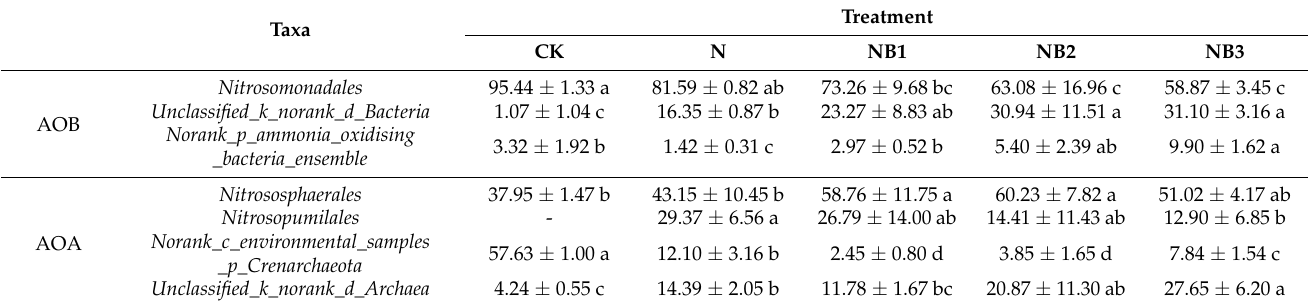
Table 4. Relative abundance (%) of predominant taxa for AOB and AOA at the order level across all the treatments.